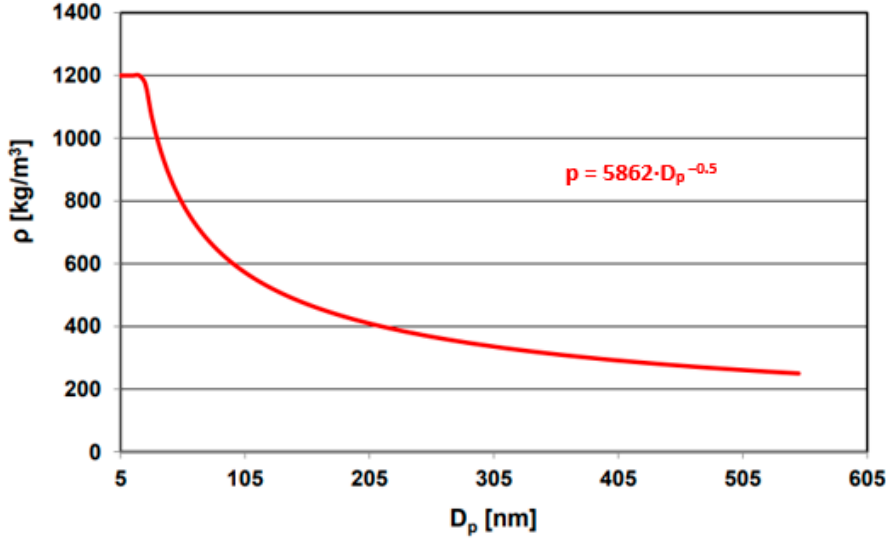
Figure 4. Density of solid particles depending on their diameter